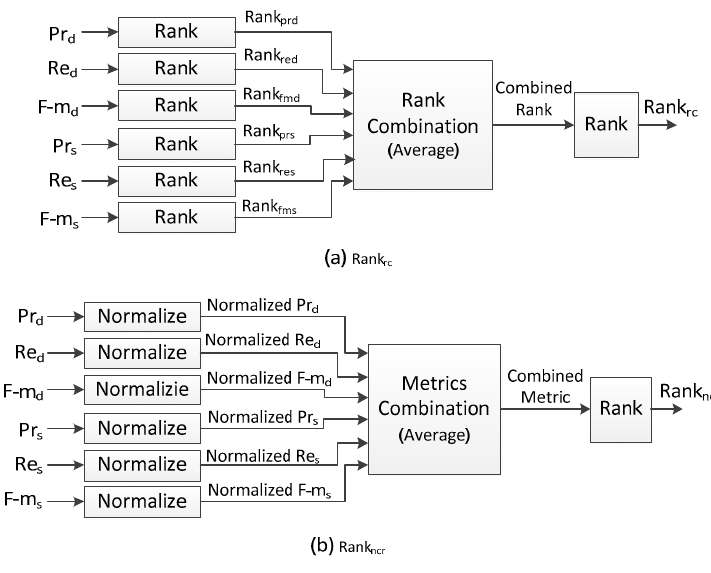
Figure 10. Two proposed rank-order rules of BS algorithms. Figure 11. Two proposed rank-order rules of BS